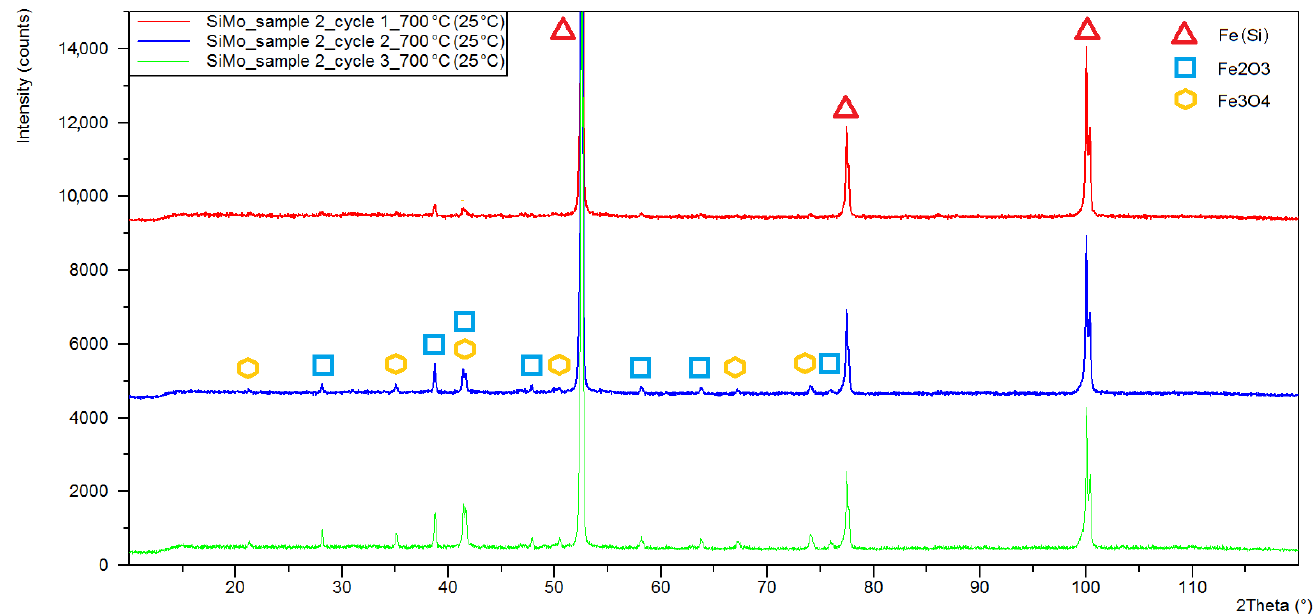
Figure 7. XRD patterns obtained for sample 2 of SiMo cast iron after one (red line), two (blue line) and three (green line) heating cycles at 700 °C.